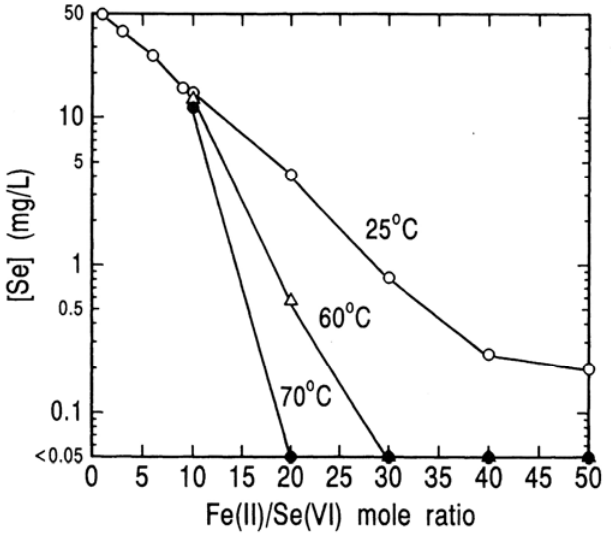
Figure 15. Effect of Fe(II)/Se(VI) mole ratio on removal of selenium(VI) by reduction with ferrous hydroxide in an atmosphere of nitrogen. [Se(VI)] 70 °C; 1